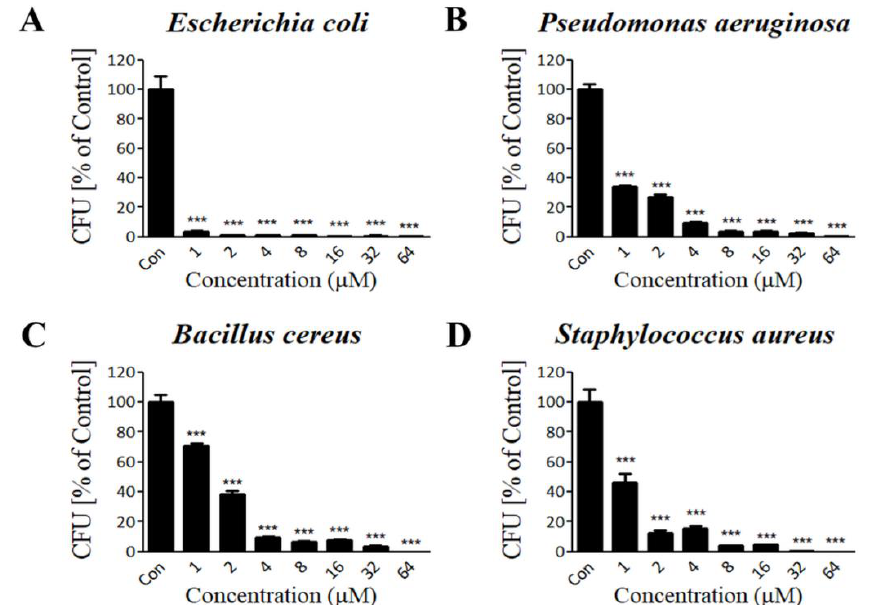
Figure 2. Antibacterial activity of Lycotoxin-Pa4a on ( A ) E. coli , ( B ) P. aeruginosa , ( C ) B. cereus , and ( D ) S. aureus . CFU assay was used to determine the antibacterial effect of the peptide. Results of triplicate experiments are represented as mean ± SEM. *** p < 0.001 indicated a significant difference compared with the control.